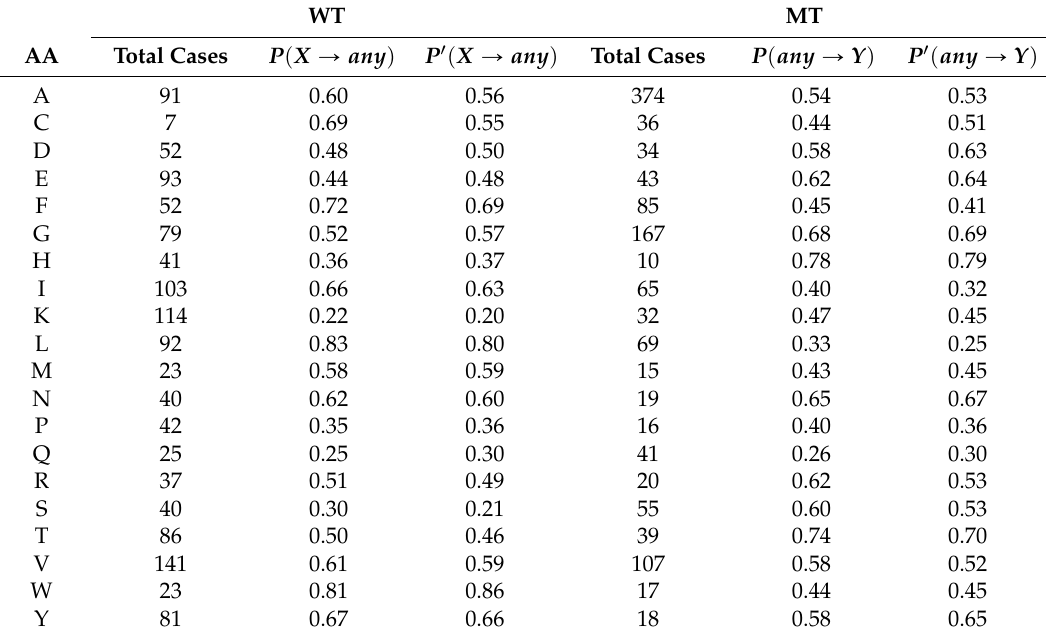
Table 1. The probabilities of the wild type (WT) and mutant type (MT) residues to cause “large effect”. The probability (P) values were calculated using unperturbed (original) | ∆∆ G |. The P 1 values were calculated using altered | ∆∆ G altered | based on Equation (2).